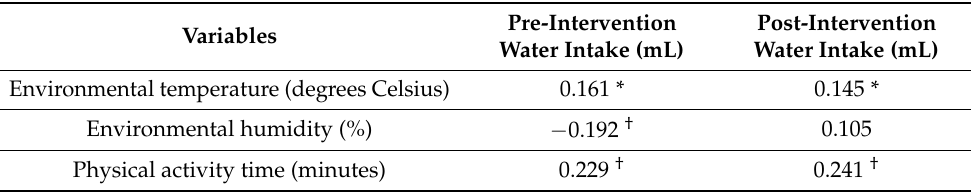
Table 4. Spearman’s rank correlation coefficients between water intake, environmental conditions, and physical activity time. Pre-Intervention Post-Intervention Variables Water Intake (mL) Water Intake (mL) Environmental temperature (degrees Celsius) 0.161 * 0.145 * Environmental humidity (%) − 0.192 † 0.105 Physical activity time